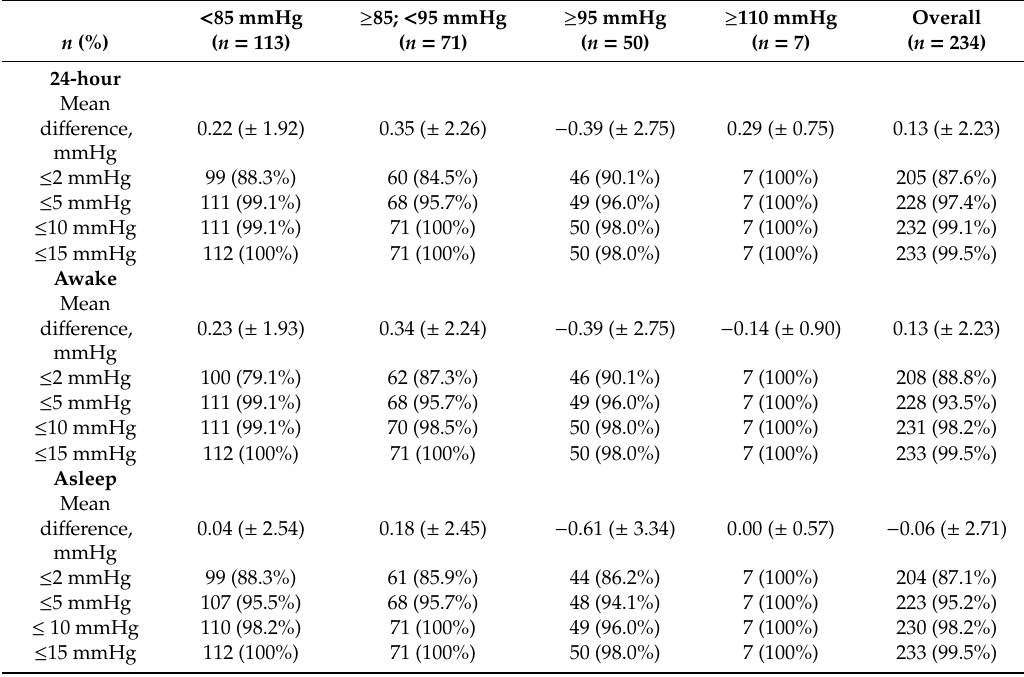
Table 7. Agreement between DominoBP and SchillerBP derived blood pressure data for mean diastolic blood pressure values in di ff erent blood pressure categories, stratified by DominoBP mean diastolic awake blood